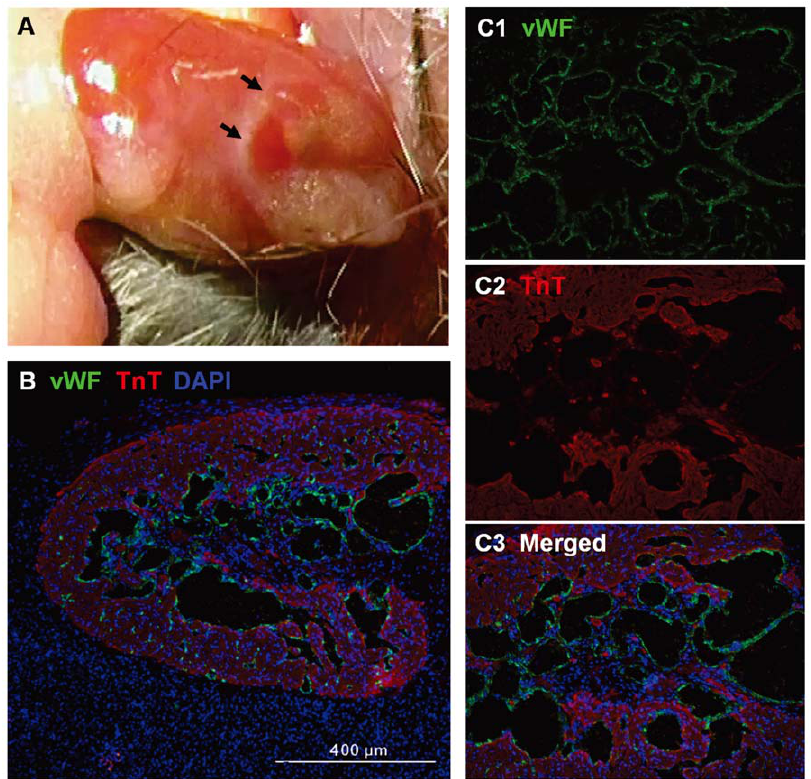
Figure 1. Characterization of fetal heart transplant. A: Typical fetal heart (arrows) on the surface of a recipient kidney 10 months after transplantation into the kidney capsule. B: Cross section of this fetal heart co-stained with vWF (green), TnT (red) and DAPI (blue). C1 and C2: Higher magnification of fetal heart visualized by vWF and TnT staining. C3: Myocardial structure changes with rich channels from the LV cavity that penetrate everywhere across the LV